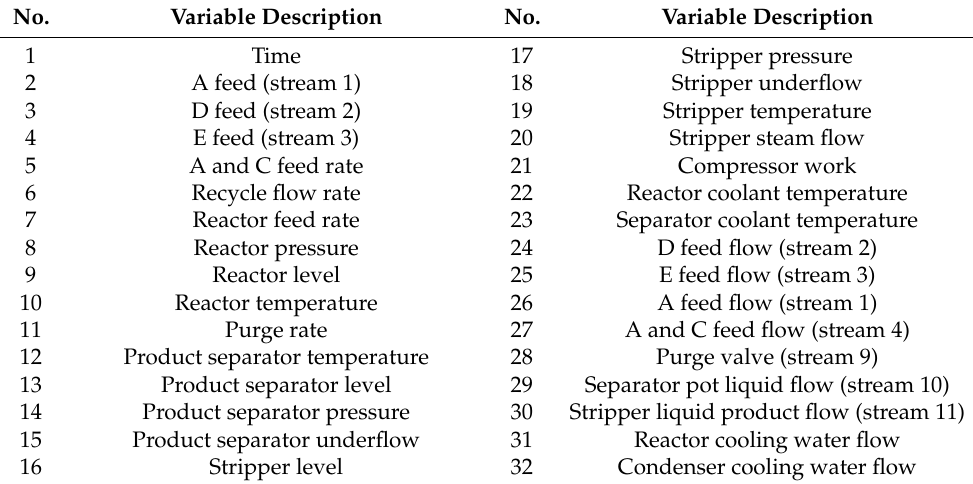
Table 1. Input variables for soft sensor development in TE chemical